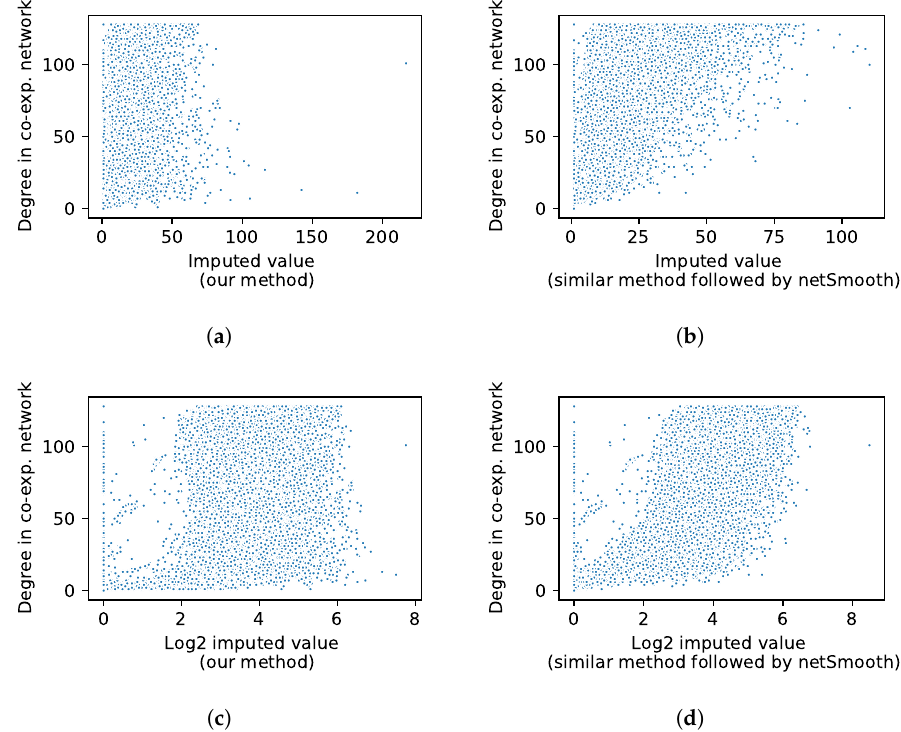
Figure 5. Scatter plot of gene’ degree in the network vs. its mean imputed values across all cells for netImpute ( a ) and netSmooth ( b ). Scatter plot of gene’ degree in the network vs. its log mean imputed values across all cells for netImpute ( c ) and netSmooth ( d